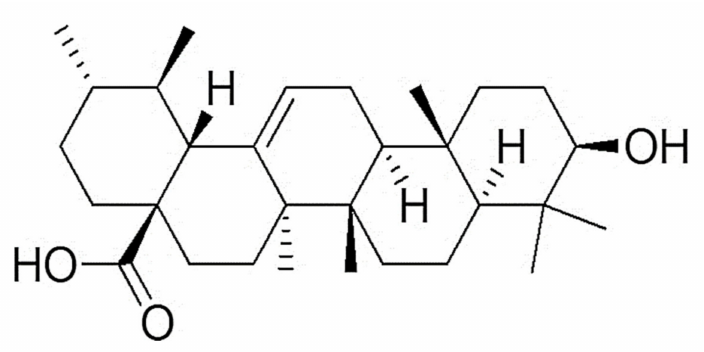
Figure 1. Chemical structure of ursolic acid